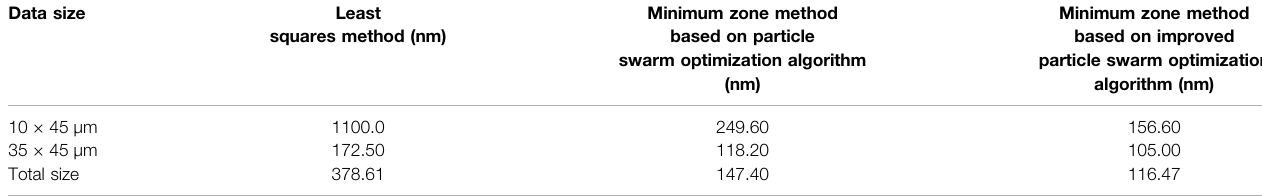
TABLE 1 | The three algorithms are based on the fl atness error evaluation results of the maximum SHS sample surface topography data. Data size